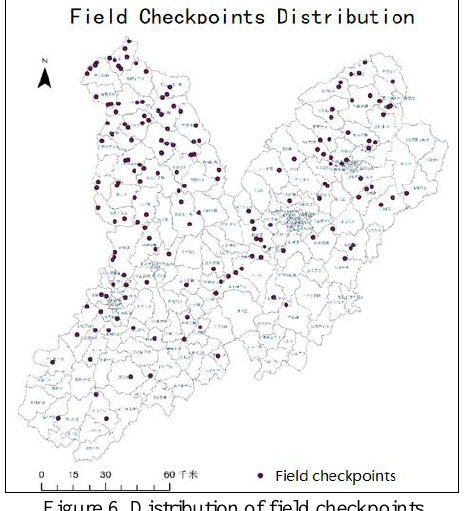
Figure 6. Distribution of field